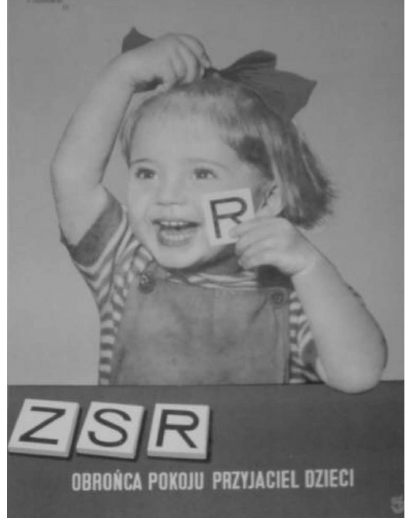
Source: https://bufetprl.com/tag/reklamy-prl/